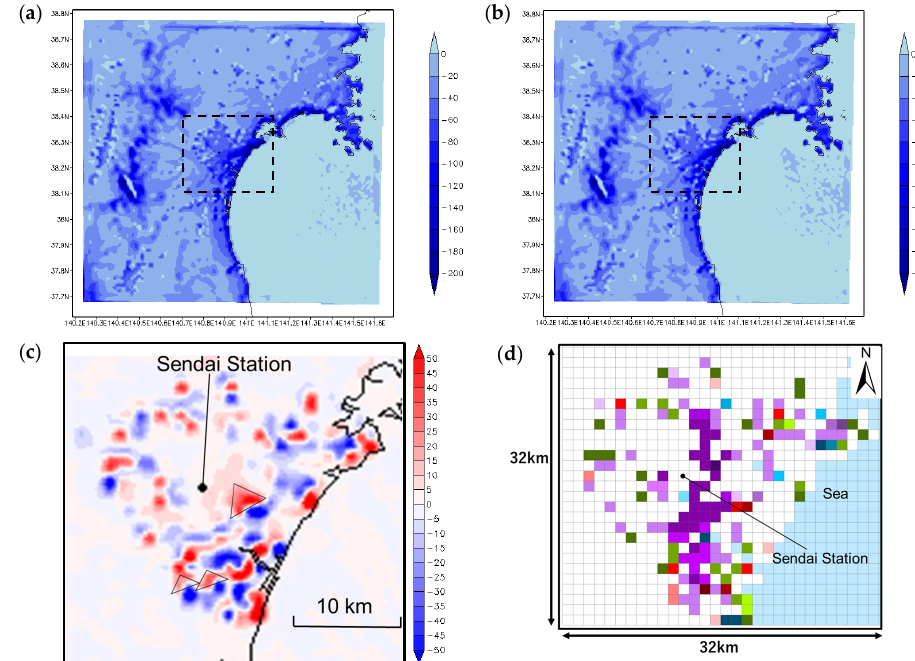
Figure 9. Daytime speci fi c humidity {g/kg’} distributions. ( a ) In Case lu_2002; ( b ) in Case lu_2022; ( c ) speci fi c humidity di ff erences (between Case lu_2022 and Case lu_2002); and ( d ) land use changes between 2002 and 2022 in Sendai (reposted Figure 4).